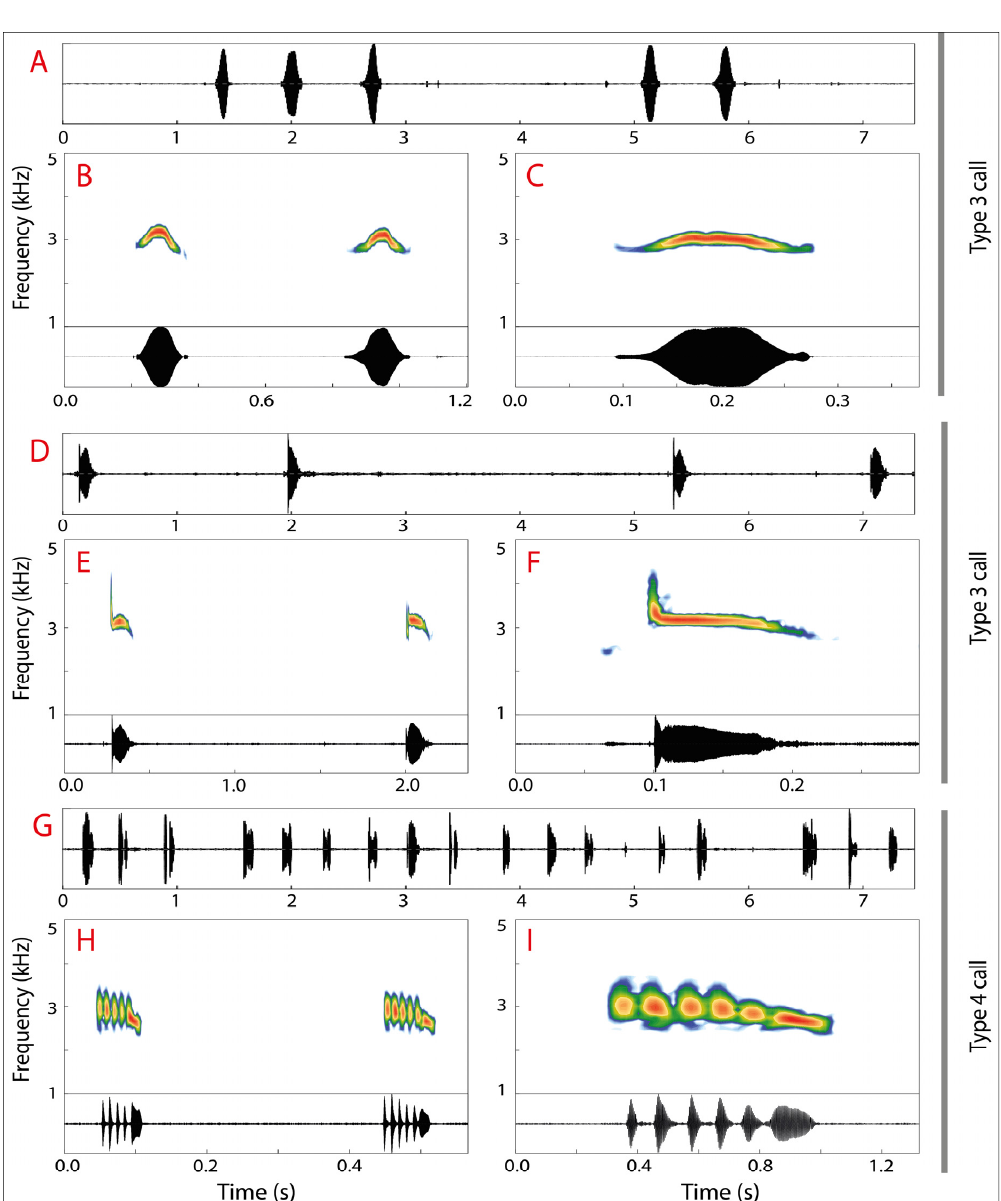
Figure 9. Type 2, type 3, and type 4 calls of Atelopus manauensis sp. nov.: ( A ) Oscillogram showing type 2 calls emitted within approximately 7.5 s; ( B ) Spectrogram and oscillogram showing two calls of the type 2 call; ( C ) A detailed view of one type 2 call; ( D ) Oscillogram showing type 3 calls emitted within approximately 7.5 s; ( E ) Spectrogram and oscillogram depicting two calls of the type 3 call; ( F ) A detailed view of one call of type 3 call; ( G ) Oscillogram showing type 4 calls emitted within approximately 7.5 s.; ( H ) Spectrogram and oscillogram showing two calls of the type 4 call; ( I ) A detailed view of one call of type 4 call. Note the difference of frequency modulation among type 2–4 calls: ( A – C ) recorded at the training area of the Centro de Instruções de Guerra na Selva do Exército Brasileiro (CIGS/EB; SVL = 20.3 mm; air temperature = 26.5 °C; INPA-H 041372); ( D – F ) recorded at Fazenda Dimona (SVL = 20.9 mm; air temperature = 26.5 °C; INPA-H 041373); and ( G – I ) recorded from the holotype at Reserva Florestal Adolpho Ducke (SVL = 21.2 mm; INPA-H 041378).